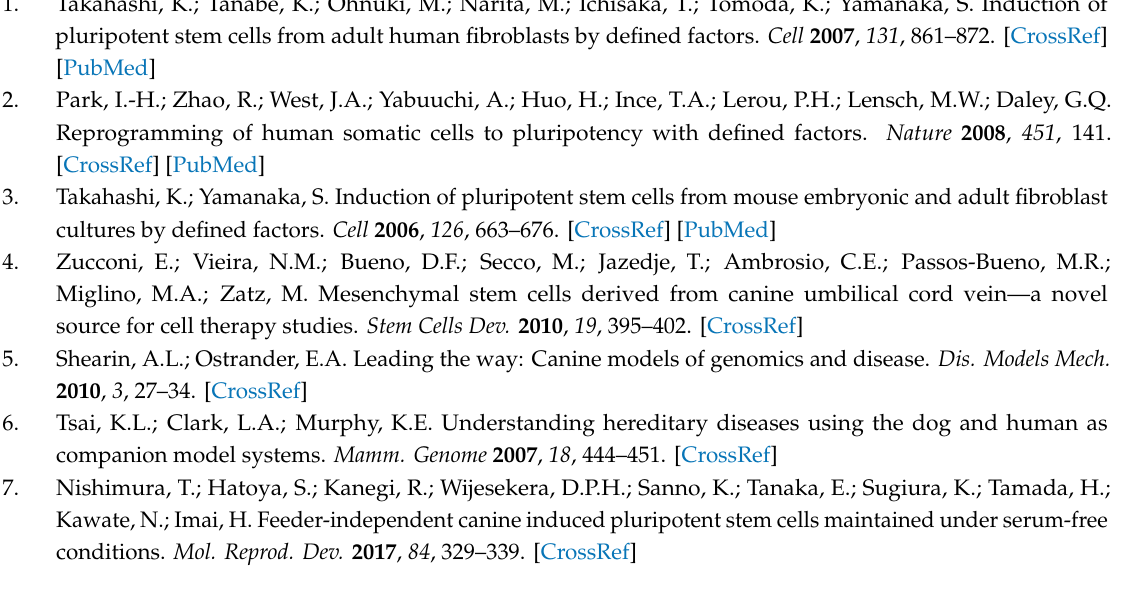
Table S1: Primers list for RT